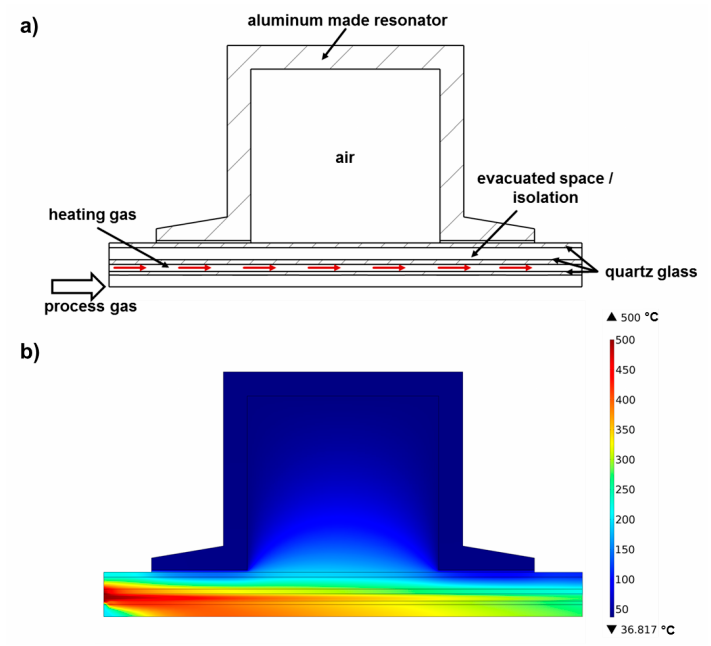
Figure 3. Thermal simulation model of the heating mechanism: Scheme of the model ( a ) and temperature distribution of a simulation ( b ).